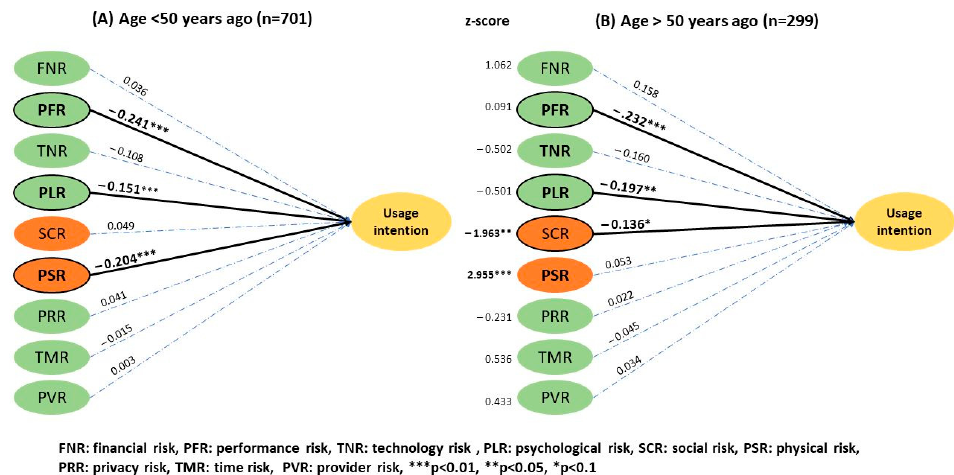
Figure 5. Results of the two-group structural model of age.